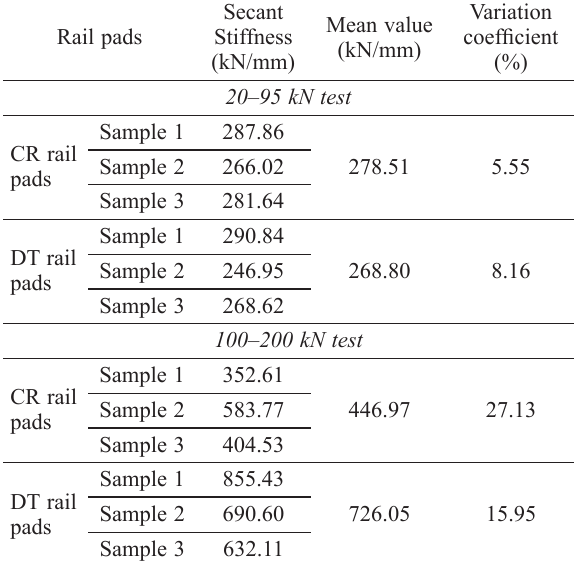
Table 2. Results obtained in the static tests for DT and CR rail pads.